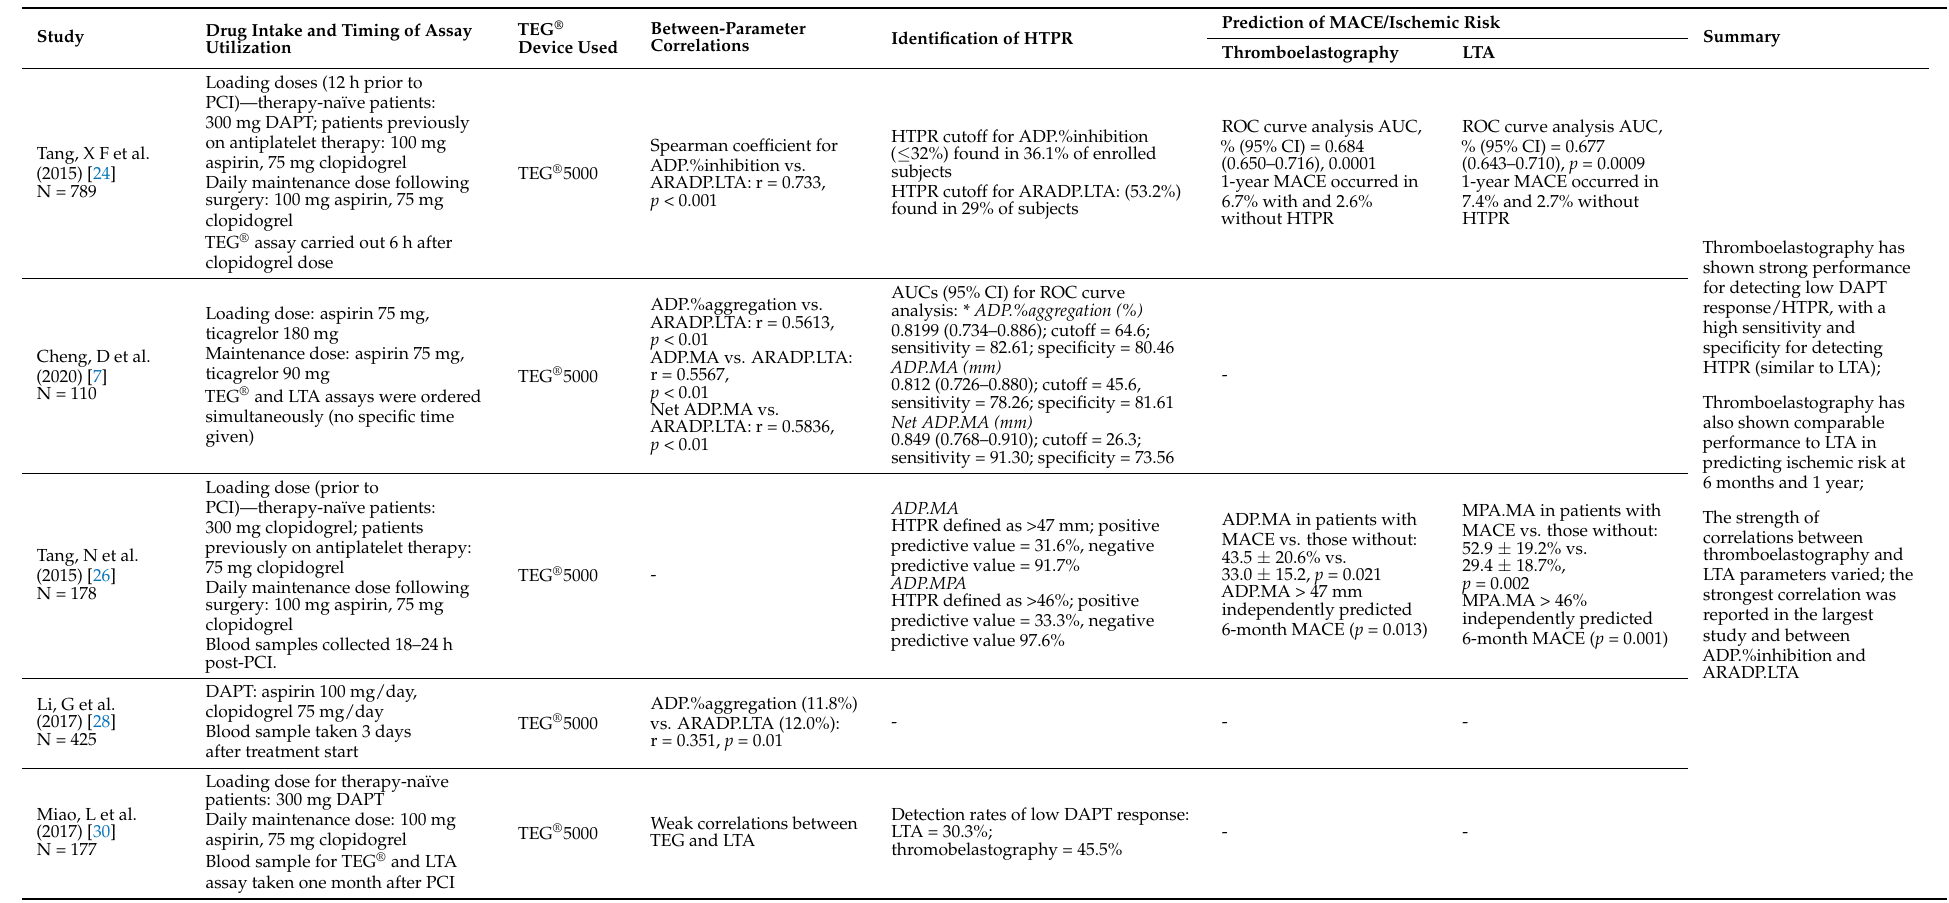
Table 3. Performance of thromboelastography with PlateletMapping ® assay vs. the current gold-standard assay in studies in China (LTA)